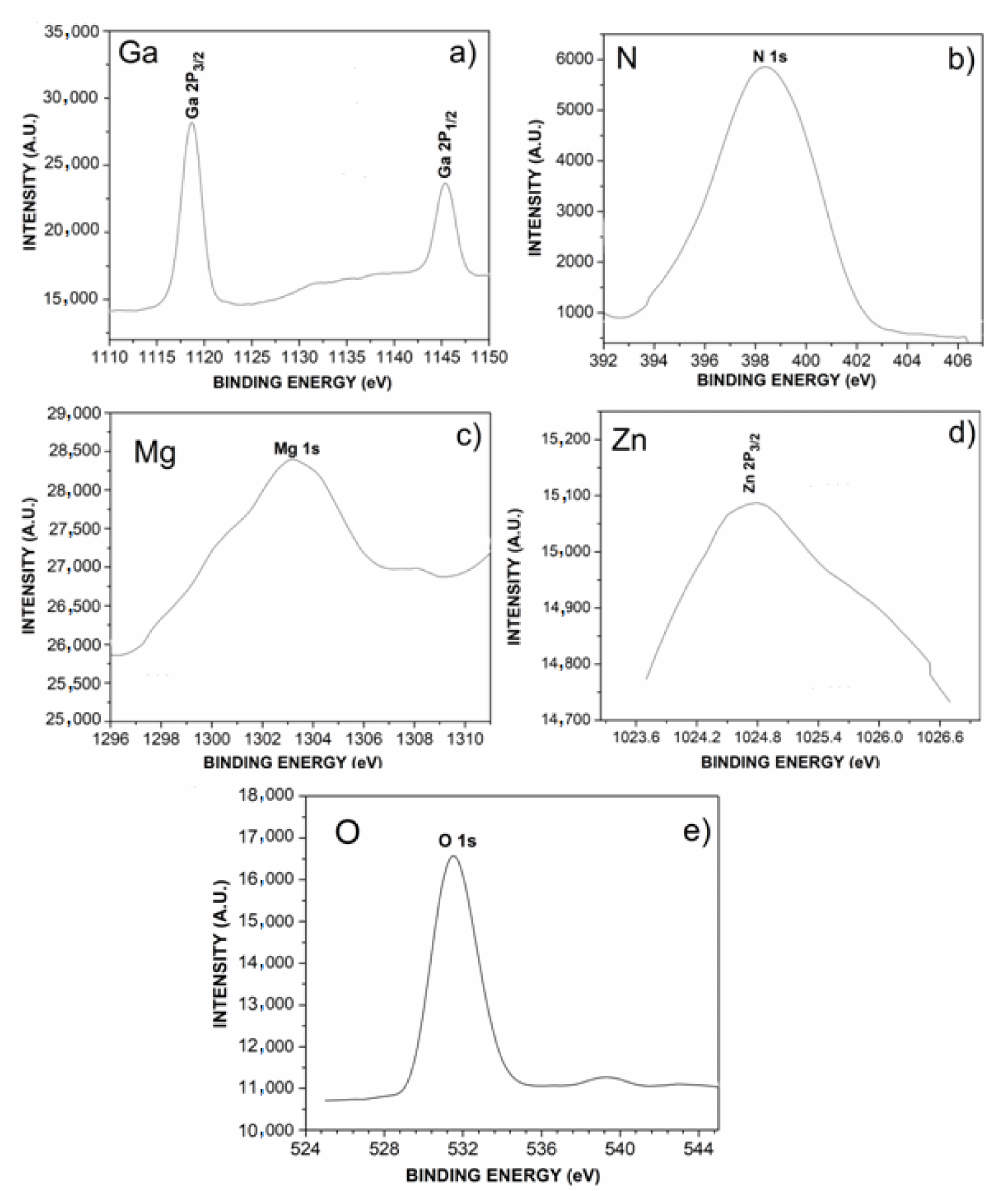
Figure 4. XPS spectra for the GaN films doping with Mg or Zn; ( a ) Ga 2P 3/2 and Ga 2P 1/2 , ( b ) N 1s, ( c ) Mg 1s, ( d ) Zn 2P 3/2 , and ( e ) O